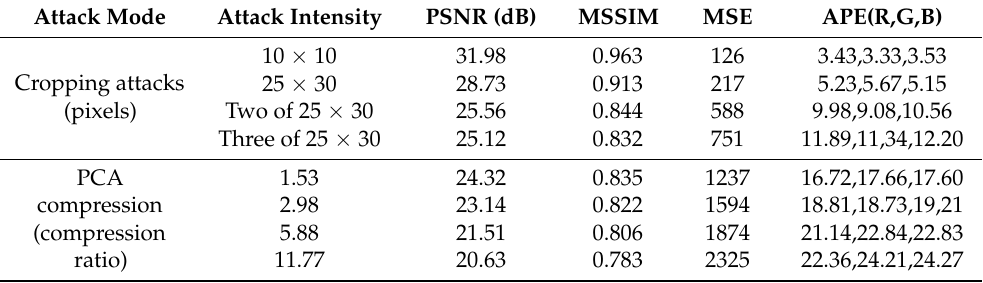
Table 3. Evaluation indexes of the reconstructed secret images from container images in Figures 12 and 13 subject to different